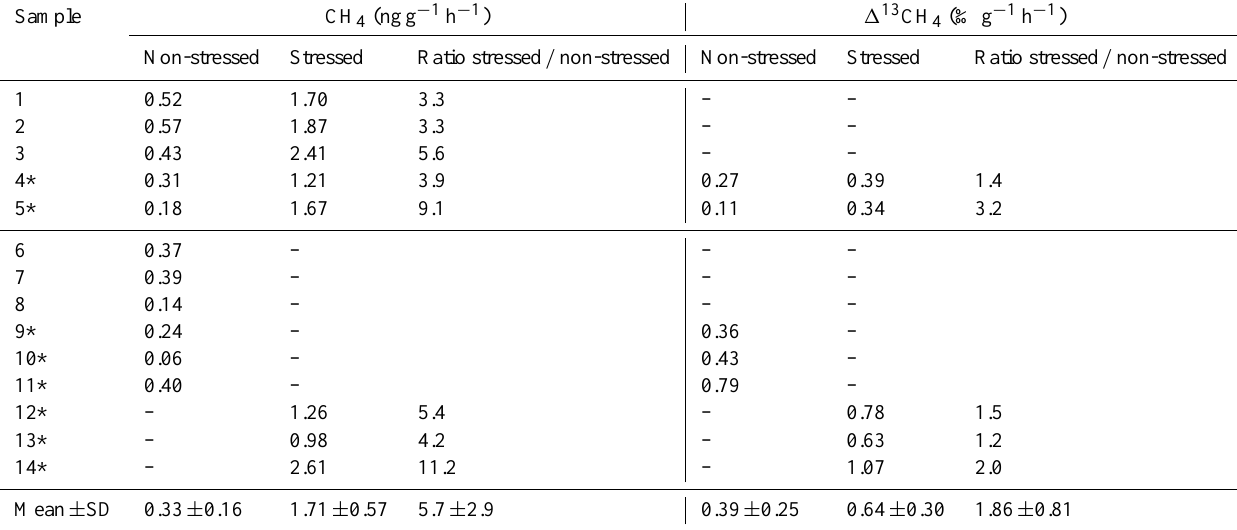
Table 1. Rates of formation and δ 13 C signature increase in CH 4 released during incubation of L. angustifolia plants before and after physical stress. Samples 1–5 were measured in experiment 1 (consecutive treatment experiment, measurements at day 1, non-stressed, and day 2, stressed) and samples 6–14 in experiment 2 (parallel treatment experiment). The difference in the CH 4 rate increase between the non-stressed and stressed treatments was significant ( p = 0 . 003 and p = 0 . 005 for experiments 1 and 2,